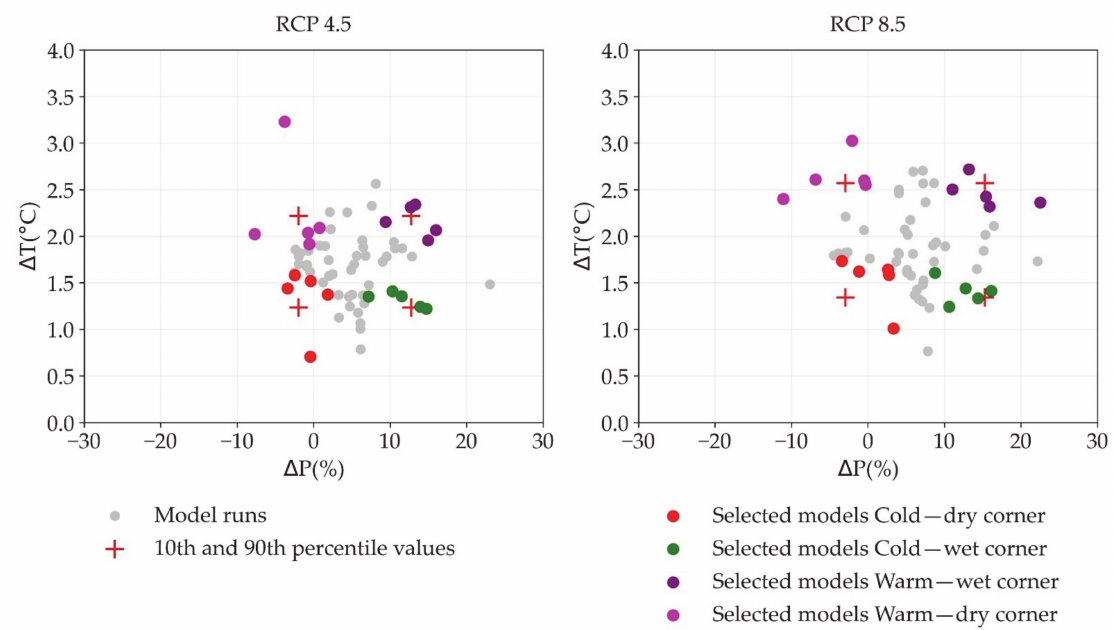
Figure 3. Projected changes in annual precipitation ( ∆ P %) and annual mean temperature ( ∆ T ◦ C) for RCP 4.5 and RCP 8.5. Pink, violet, red, and green dots represent warm-dry, warm-wet, cold-dry, and cold-wet conditions,